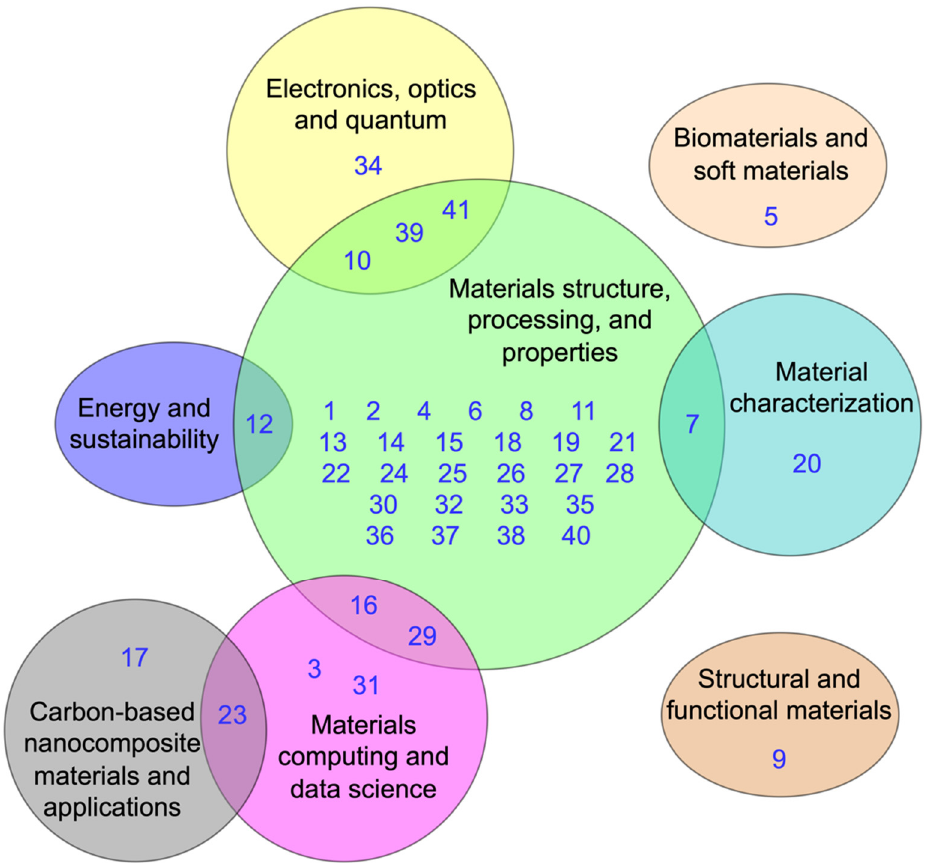
Figure 2. Area of MSE in which described applications are circumscribed. Numbers 1 to 41 identify the works listed in Table 4 (column “Work Number”).